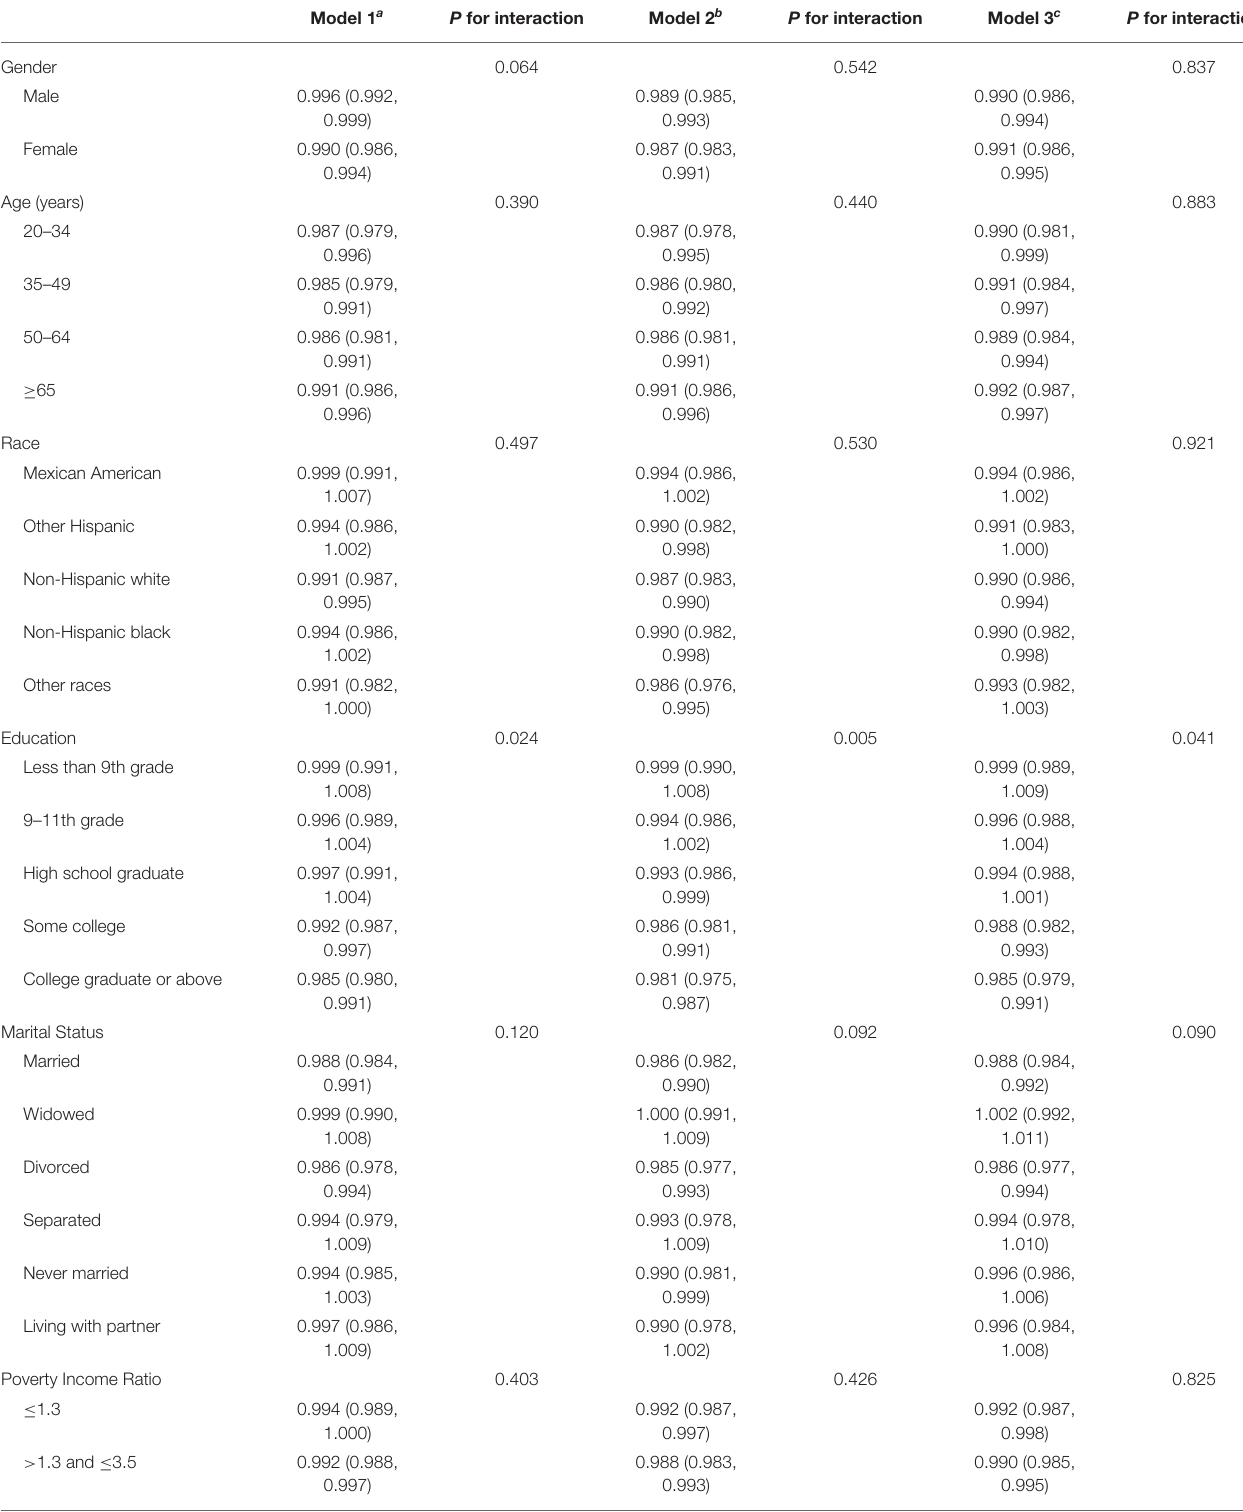
TABLE 4 | Stratifiedlogistic regression analysis to identify variables that modify the correlation between HEI-2015 and kidney stones a